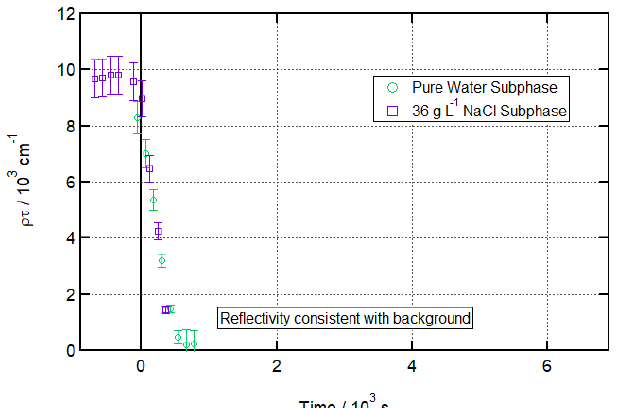
Figure 1. Ozonolysis of an oleic acid monolayer floating on pure vs. salt water. Time evolution plot for ozonolysis of 29µL 1.0gL − 1 d 34 -OA (CHCl 3 spreading solution) on pure water (green circles) and 25µL 1.0gL − 1 d 34 -OA 36gL − 1 NaCl(aq) (purple squares) subphases by 323 ± 29ppb O 3 introduced at t = 0s at 21 ± 1 ◦